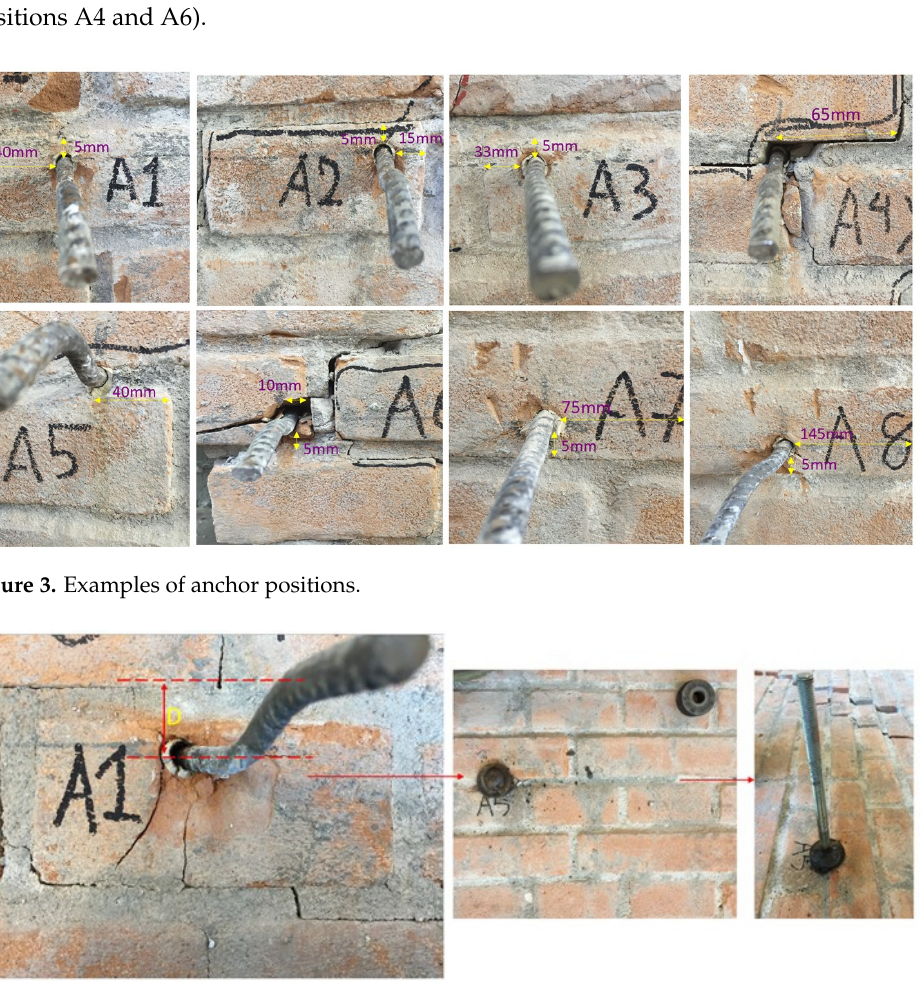
Figure 4. Anchor preparation for testing.